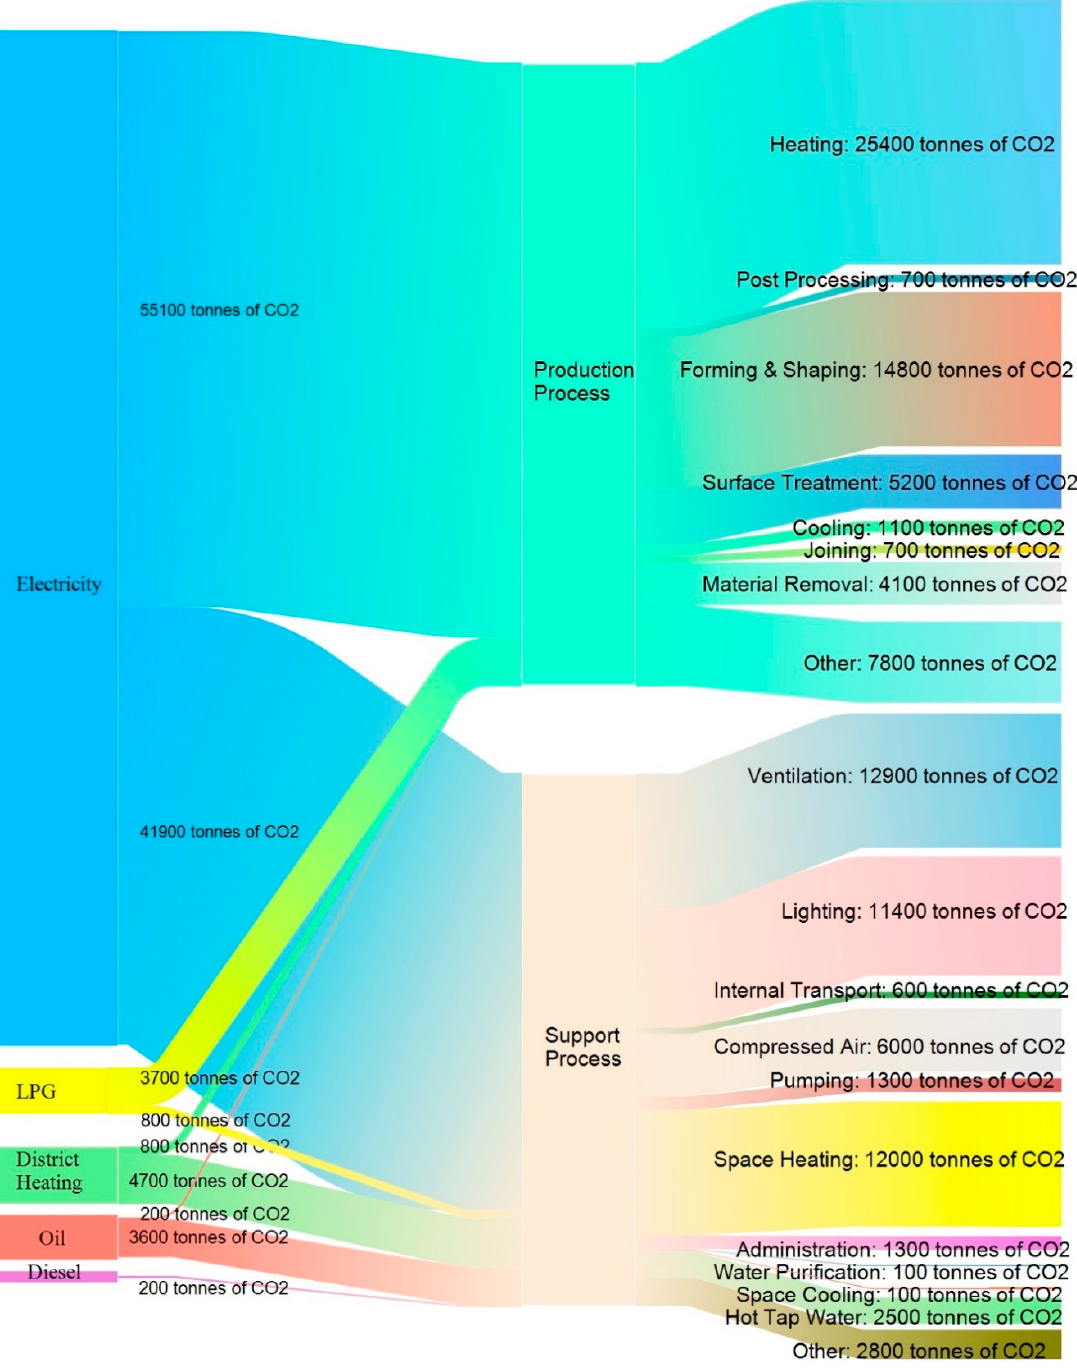
Figure 12. CO 2 emissions for each category at different levels of taxon in the Swedish engineering industry based on scenario 2, where marginal electricity and marginal district heating are considered (values are rounded to nearest 50 or 100).